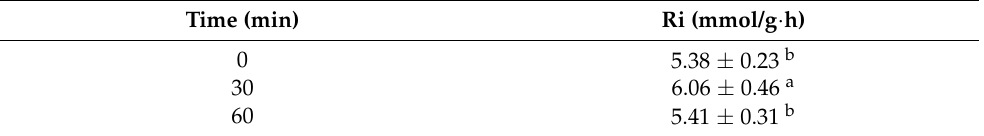
Table 1. Respiration activity of S. albulus SAR 14-116 in ultrasound-assisted fermentation.